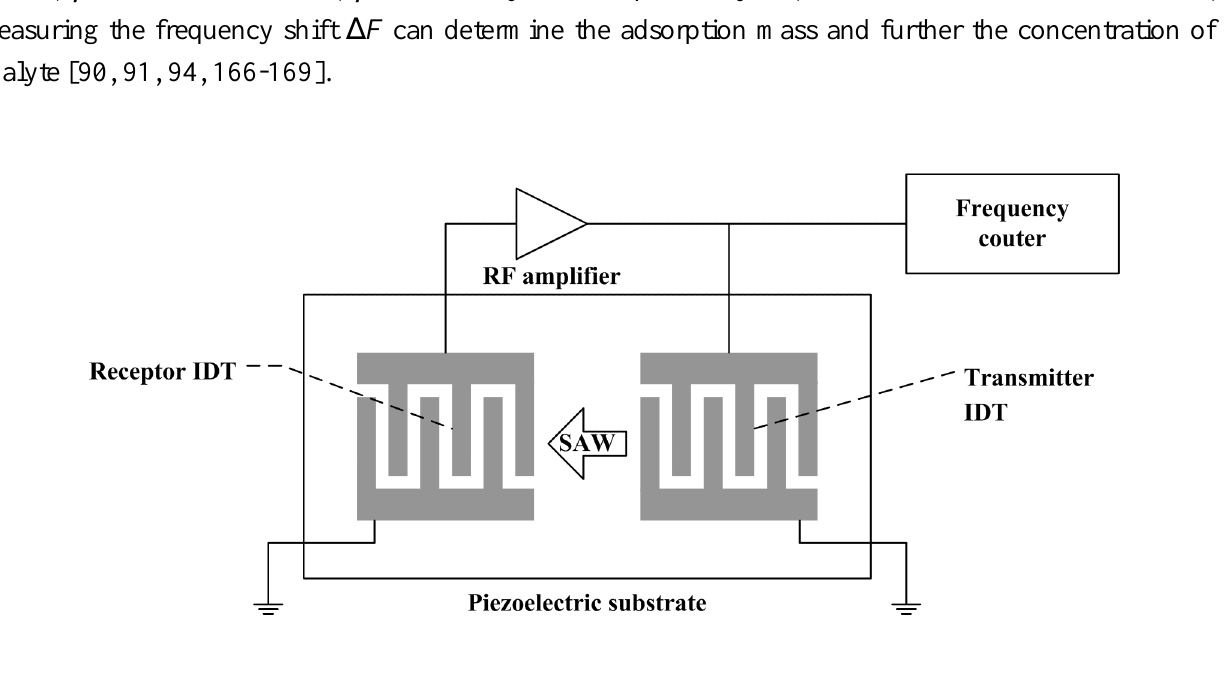
Figure 11. Configuration of surface acoustic wave sensor